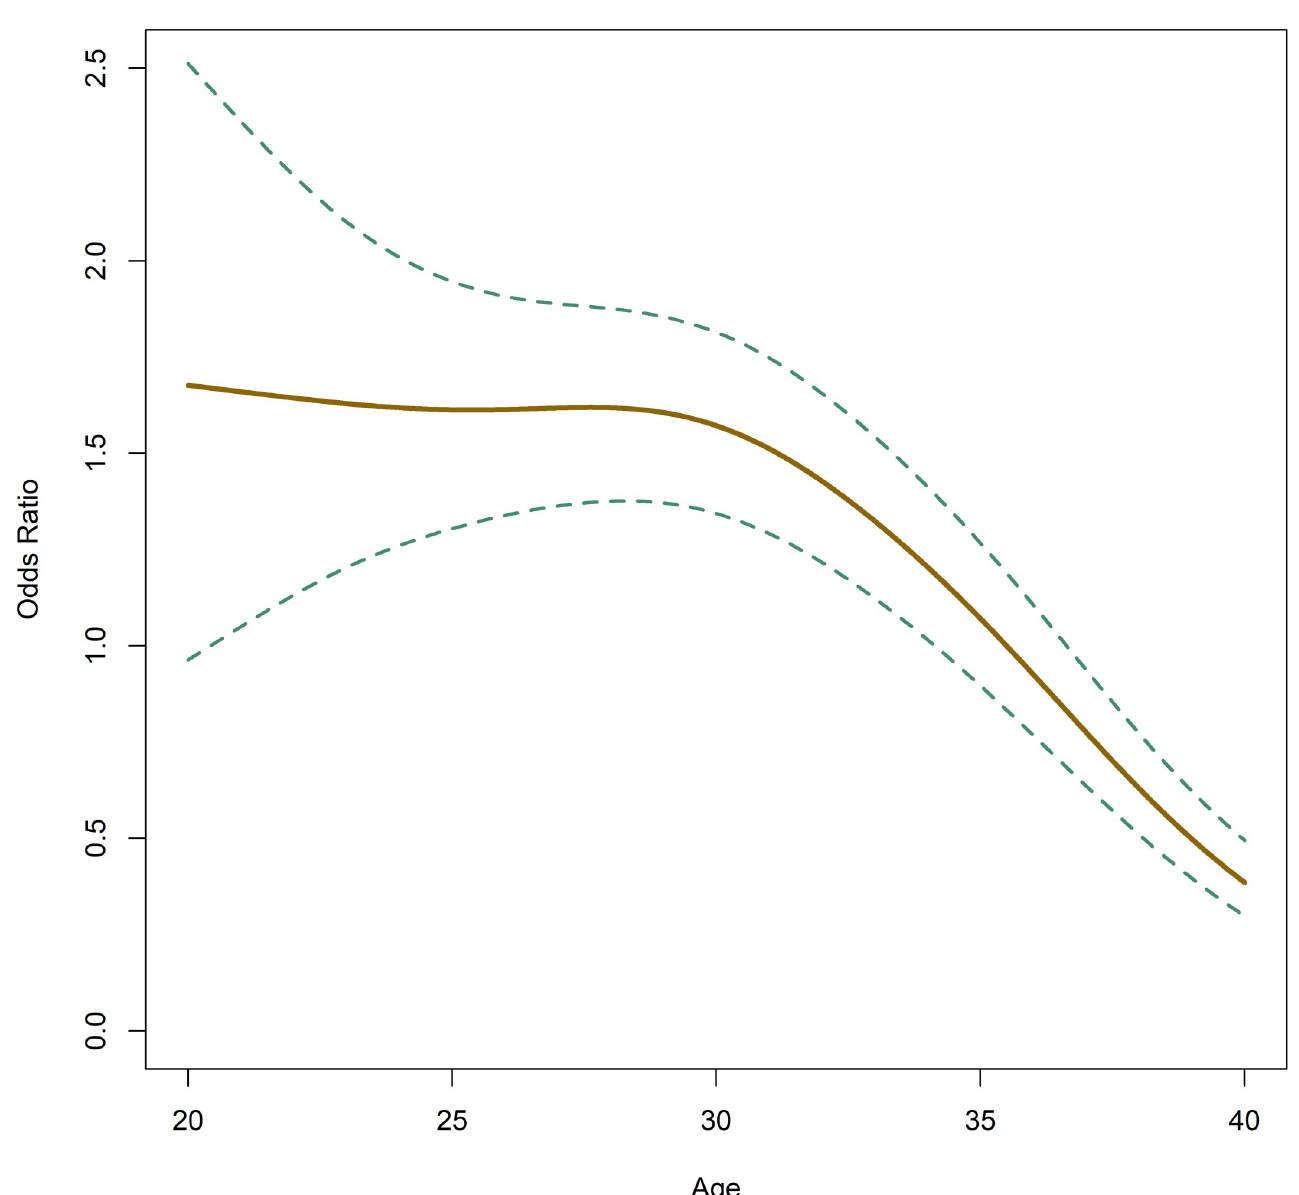
Fig 5. Odds ratio regarding live birth relative to patient age. Dashed lines show the 95% confidence intervals (CI).